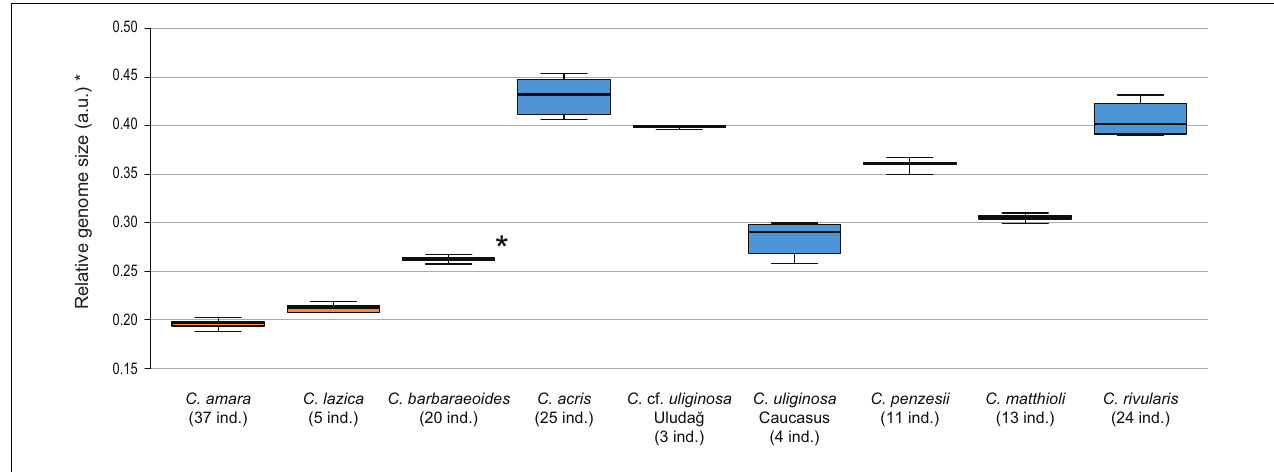
FIGURE 2 | Genome size variation of the Cardamine species under study, based on flow cytometric analyses. Relative nuclear DNA content inferred from DAPI measurements is presented, given as the ratio of the sample and standard G1 peaks (2C values in arbitrary units, a.u.). In the tetraploid Cardamine barbaraeoides (marked by asterisk), however, DNA content of the meiotically reduced genome (corresponding to the 2 x level) is assessed and presented. Population C018 of Cardamine acris was omitted because of its divergent DNA content and unclear ploidy level (see Supplementary Data Sheet 1 ). Boxplot graphs show the 25th and 75th percentiles (boxes), median values (vertical lines within boxes), and minimum to maximum values (whiskers). Orange color is used for species of the Cardamine amara group, blue for the other diploids, and black for the tetraploid C. barbaraeoides . The number of analyzed individuals per species is indicated. See Supplementary Data Sheet 1 for more details and population-level values.